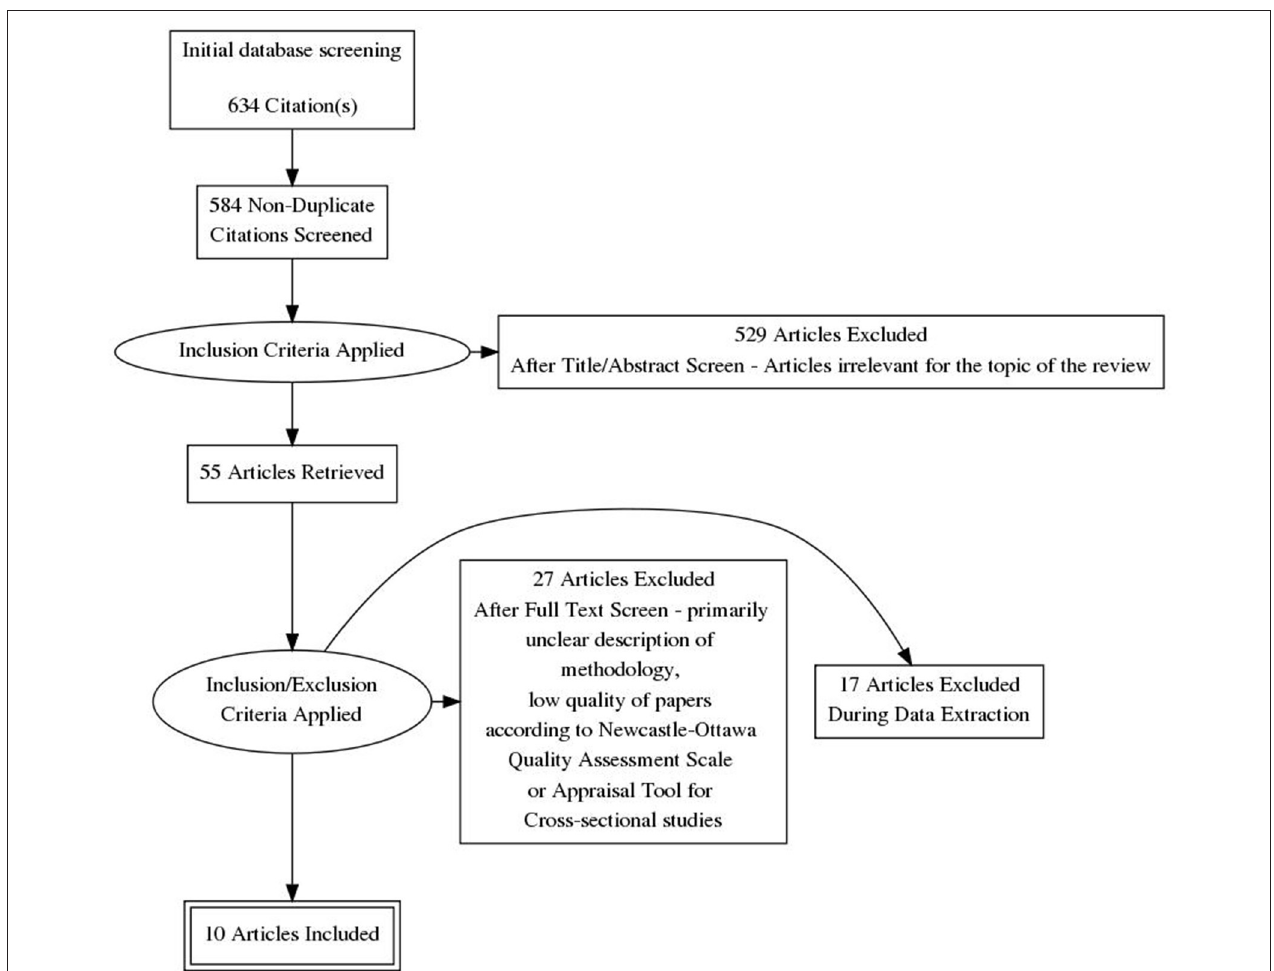
FIGURE 1 | Procedure for qualifying publications for